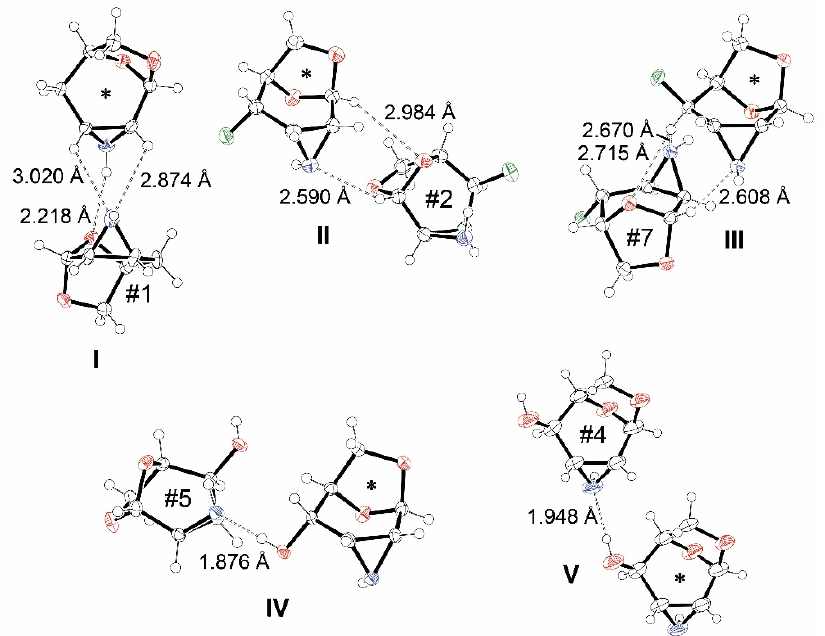
Figure 4. ORTEP presentation of the strongest intermolecular interactions found in the structures of exo ‐ epimines I – V . * denotes a parent molecule. exo -epimines I – V . * denotes a parent